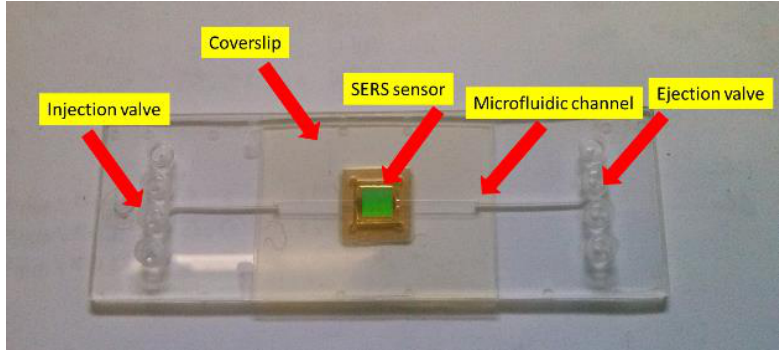
Figure 2. The microfluidic cell with the SERS sensor.